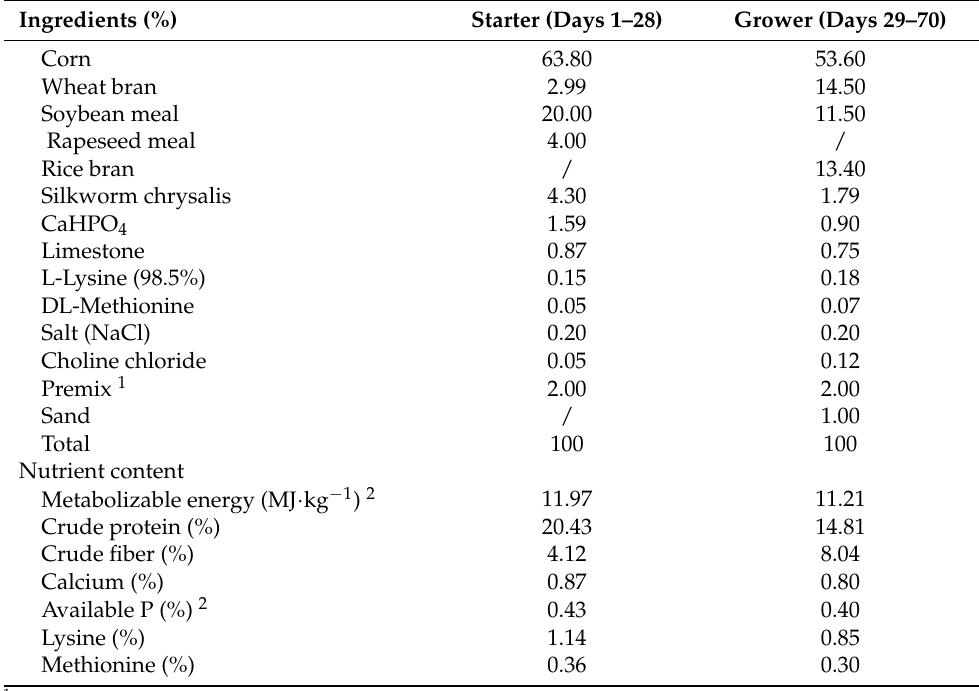
Table 1. Composition and nutrient content of basal diets (dry